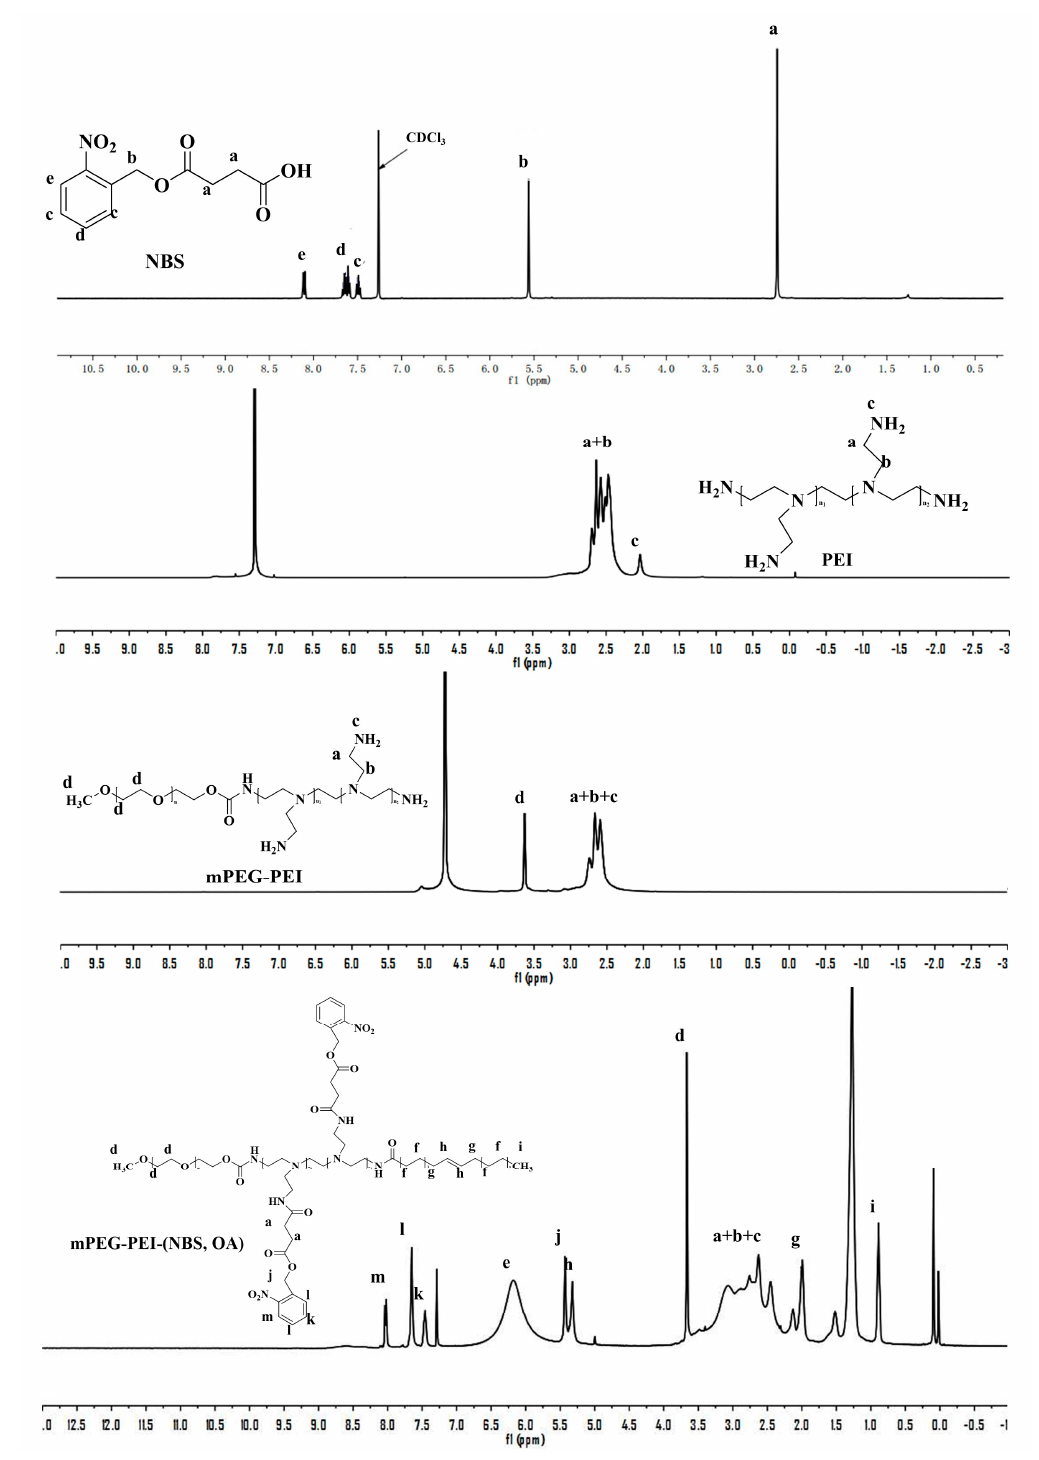
Figure 4. 1 H NMR of o -nitrobenzyl succinate (NBS), PEI, mPEG-PEI, mPEG-PEI-(NBS, OA).